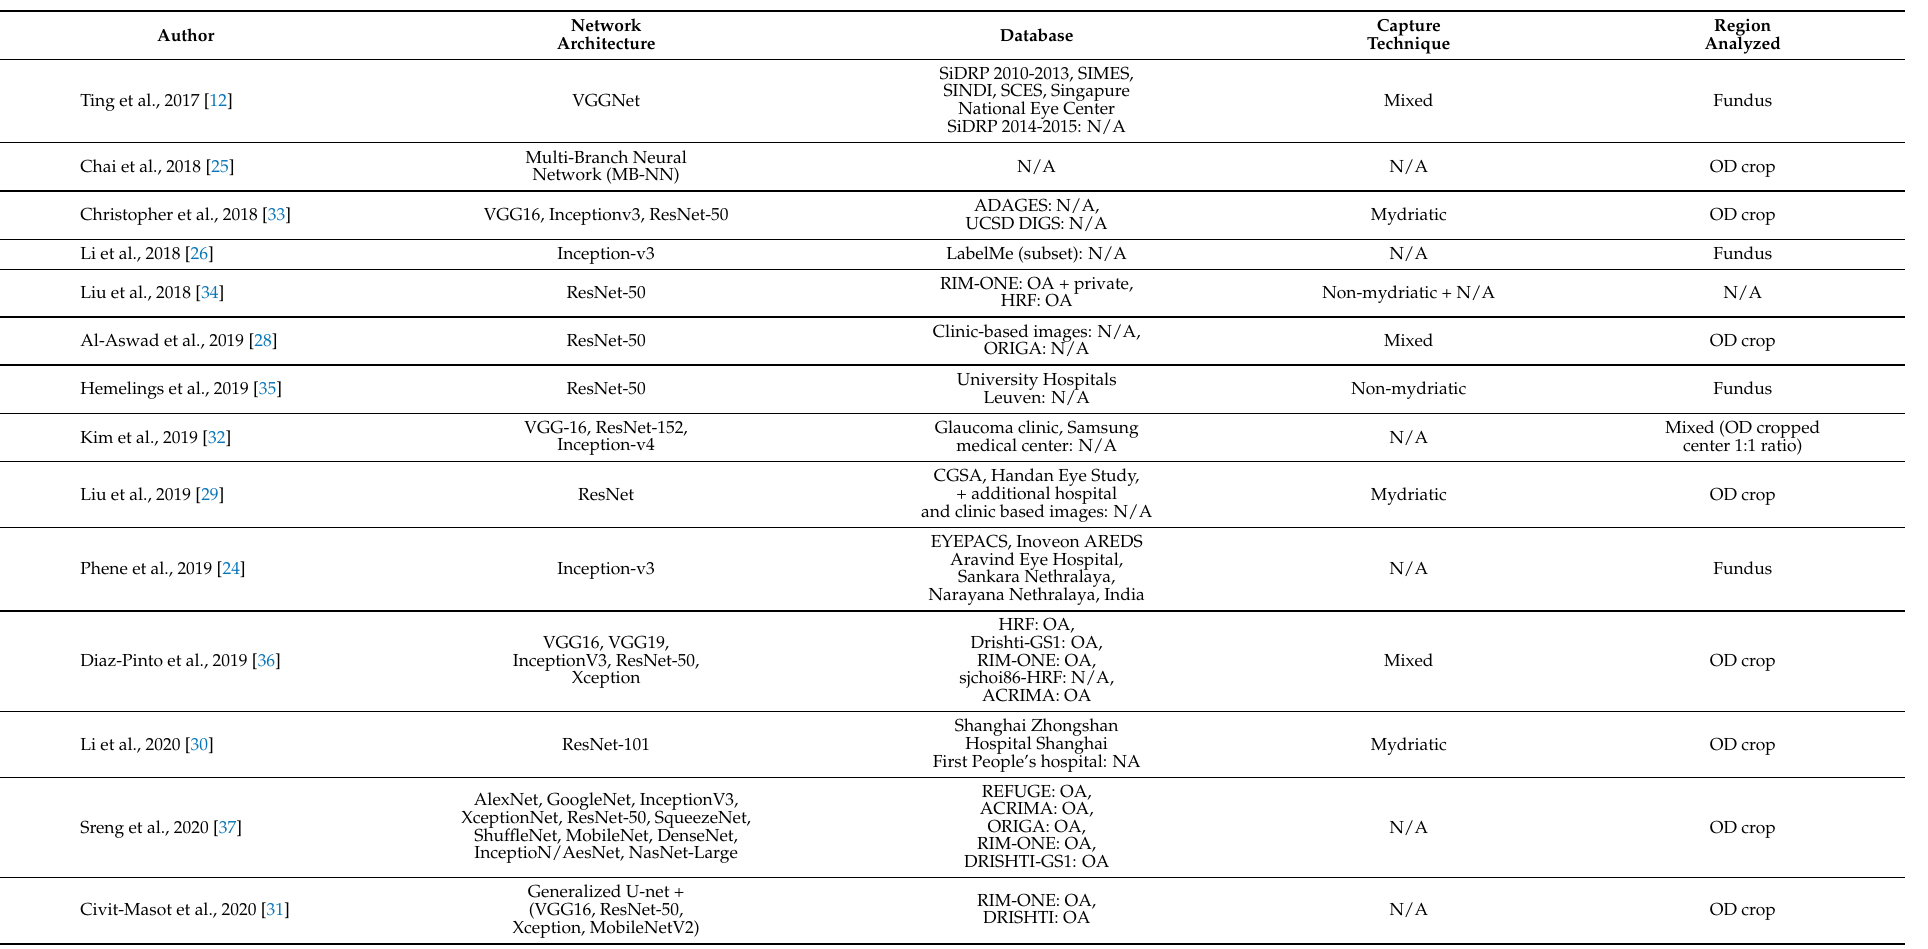
Table 1. Results from recent AI systems for GON classification Non-Referable GON (NO-GON) vs. Referable GON (R-GON) based on CFP as